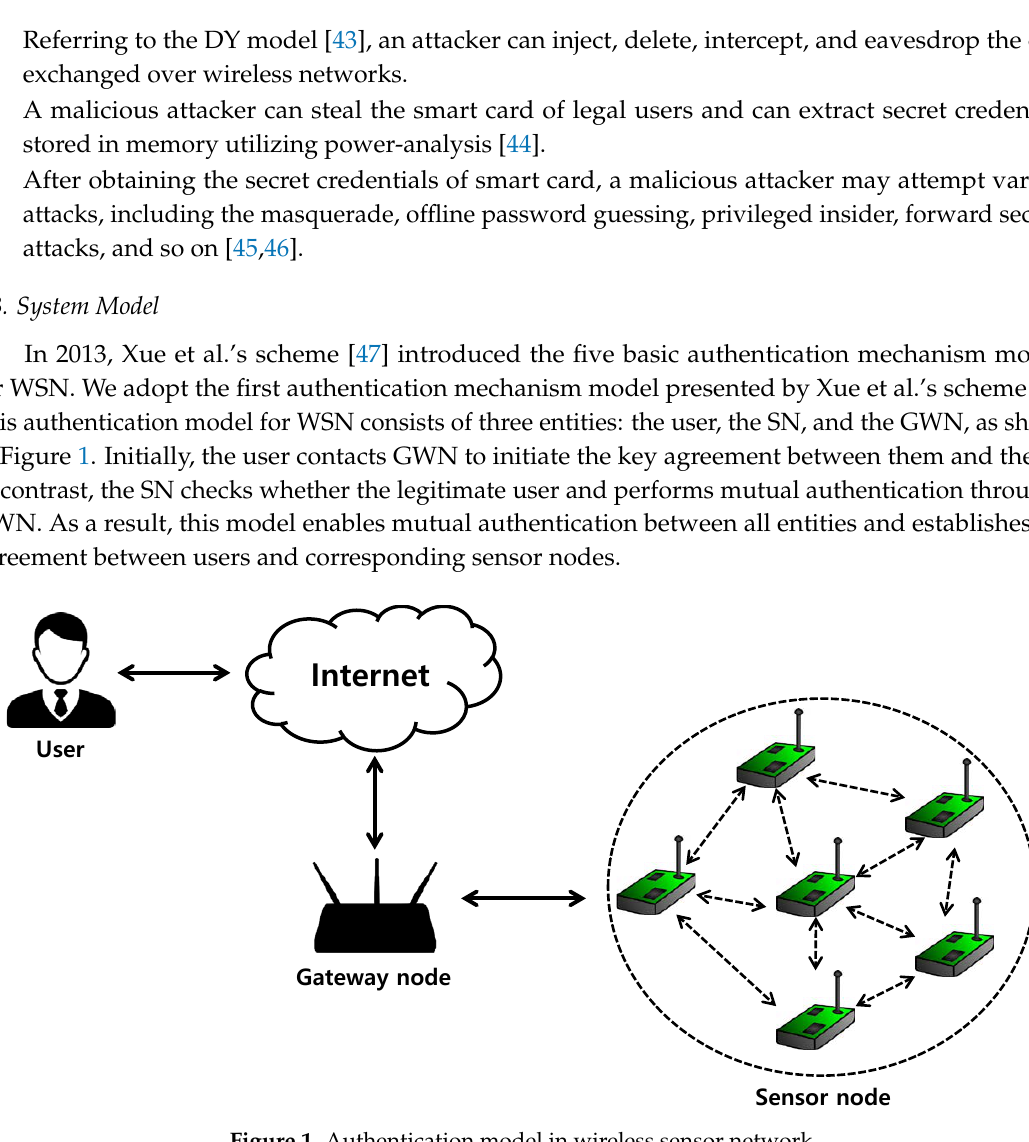
Figure 1. Authentication model in wireless sensor